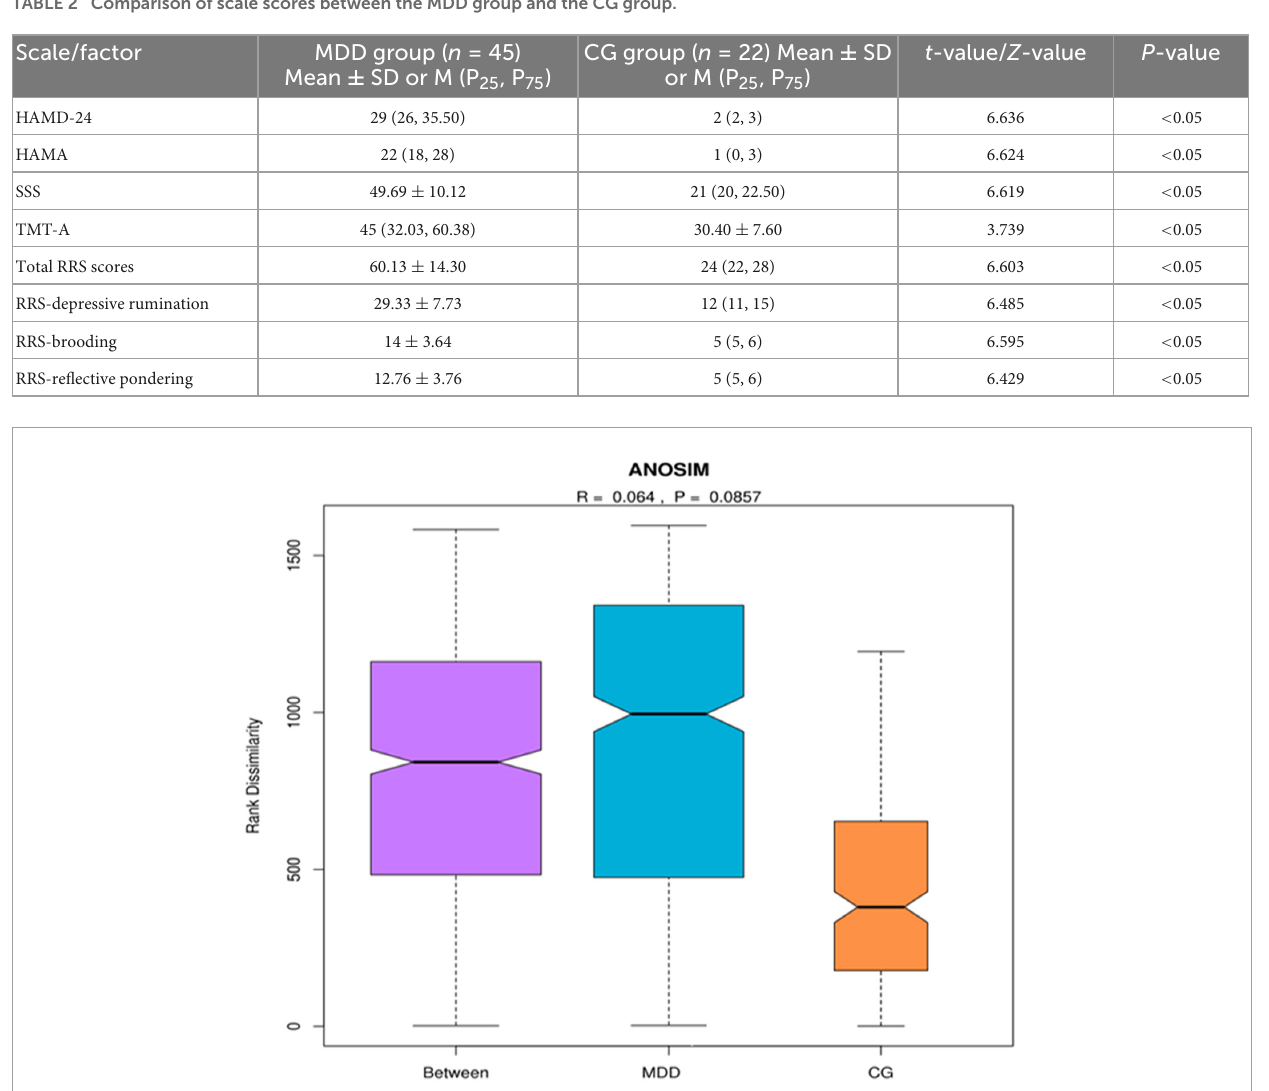
FIGURE1 Analysis of similarities. MDD group refers to the major depressive disorder group, and C group refers to the healthy control group. When R ∈ (–1, 1) and R > 0, there was a significant inter-group difference, and when R < 0, the intra-group difference was higher than the inter-group